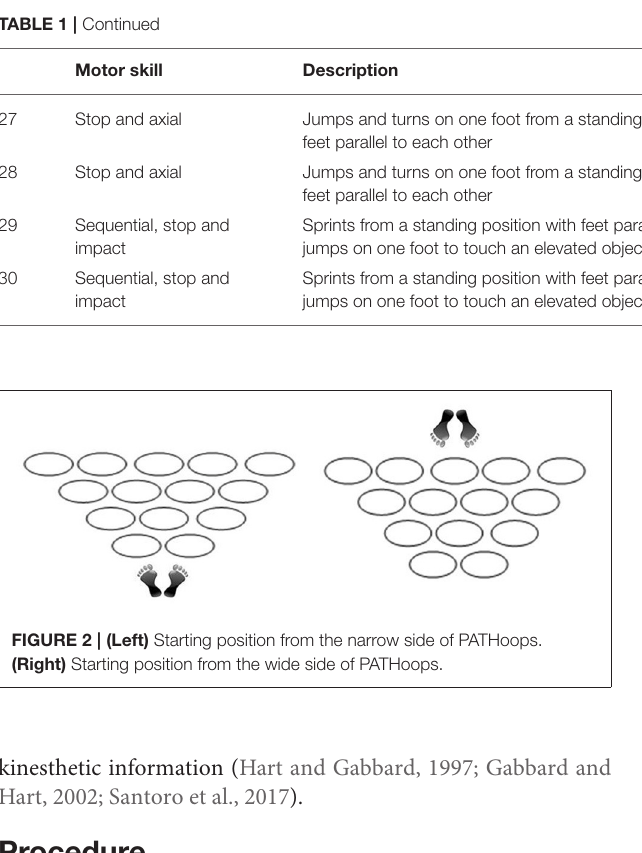
kinesthetic information (Hart and Gabbard, 1997; Gabbard and Hart, 2002; Santoro et al.,